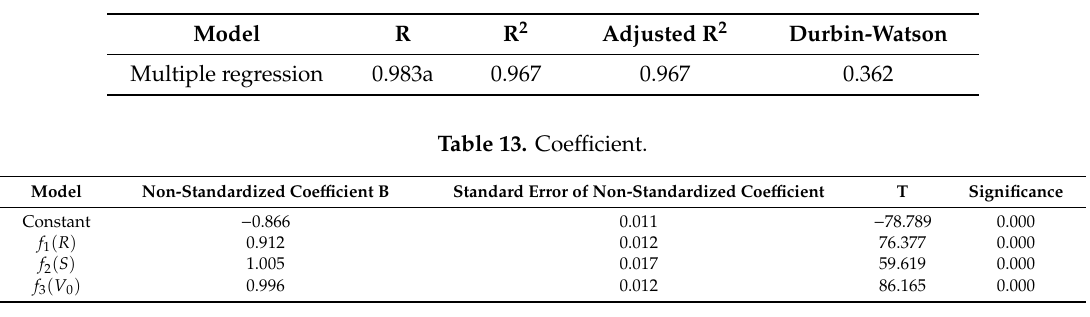
Table 10. Residuals, Akaike’s information criterion (AIC) and Bayesian information criterion (BIC)